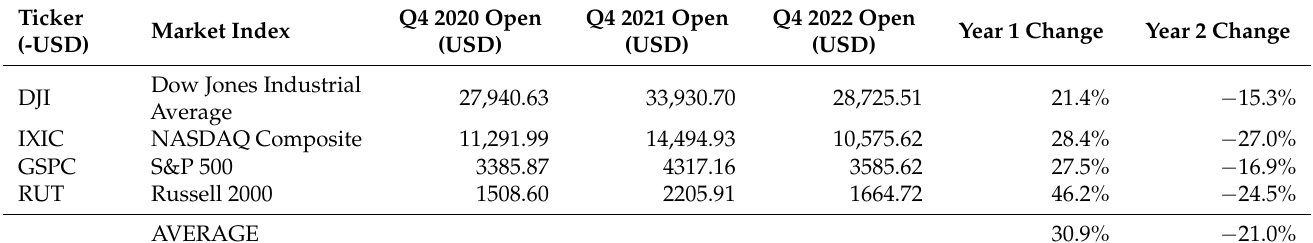
Table 3. Major market indices.